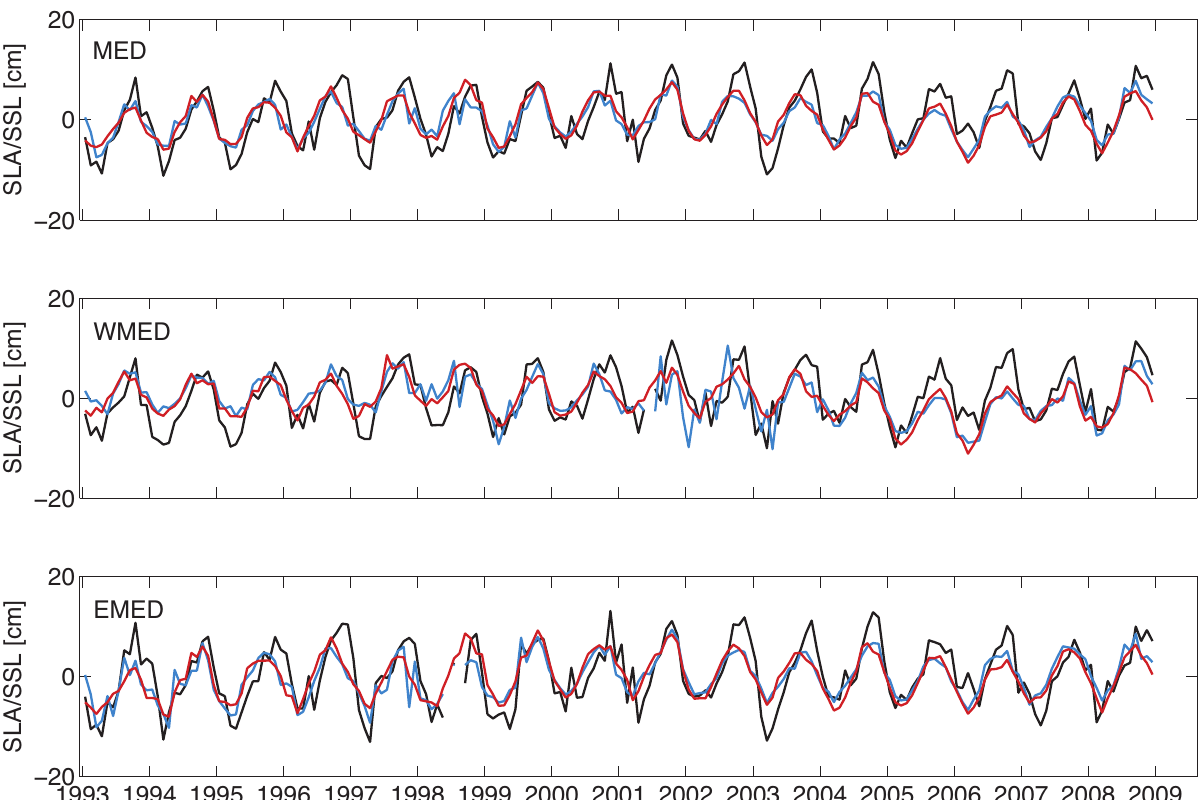
(EMED) Mediterranean